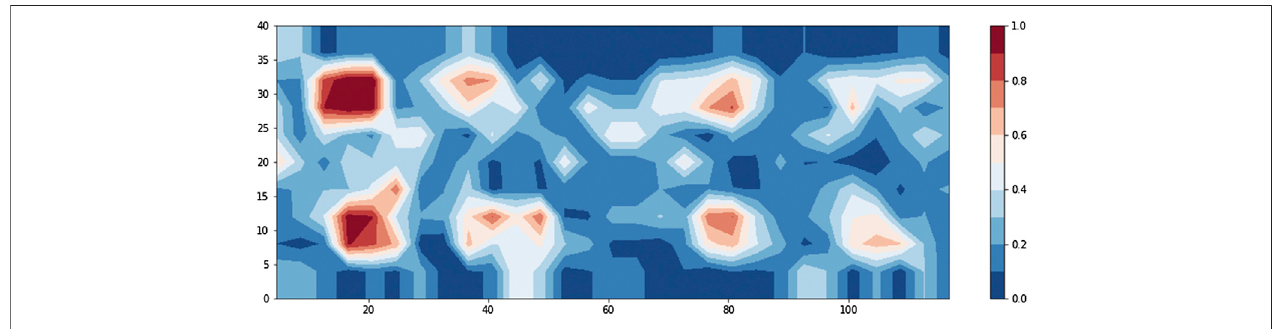
FIGURE 7 | Heat map showing con fi dence of defect